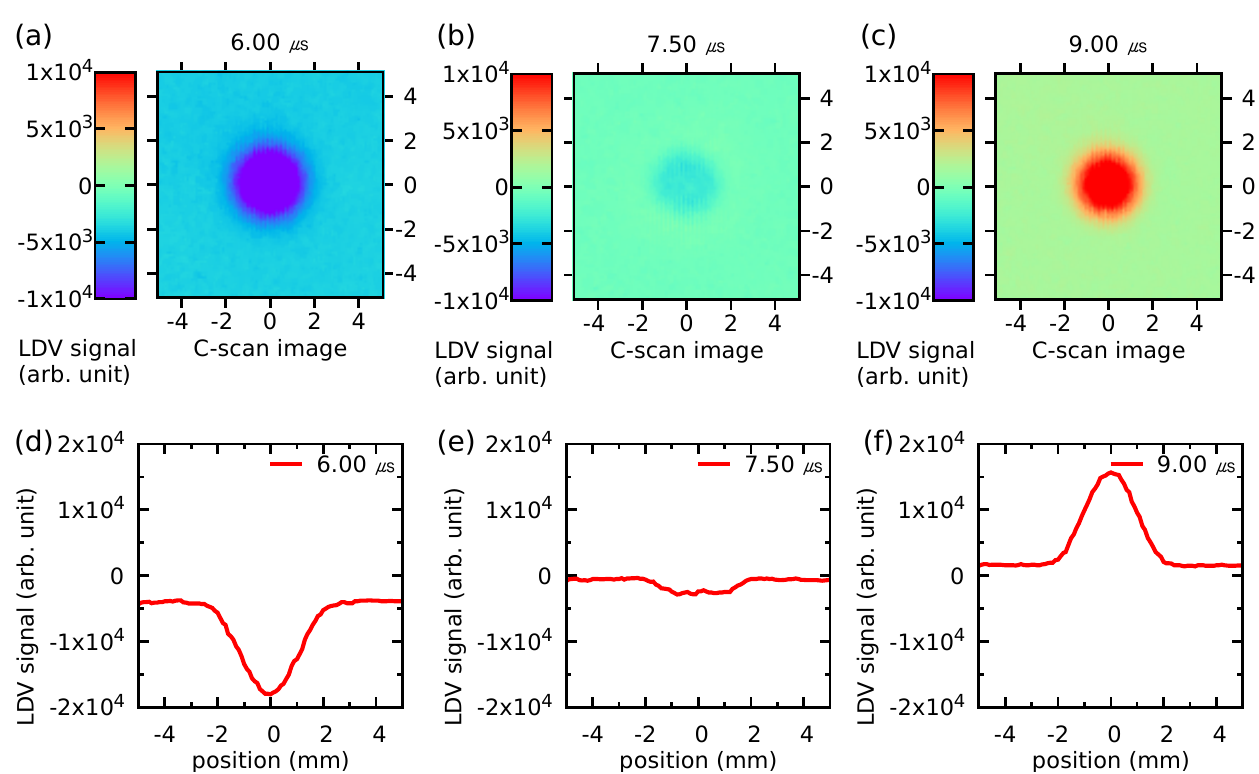
Figure 5. LDV signal distribution for Defect-1.0 of the AL6061 specimen in Band1 and its variation over time: ( a – c ) C-scan images at 6.00, 7.50, and 9.00 µ s, respectively, and ( d – f ) LDV signals as a function of the x -position at the same measuring time as in ( a – c ), respectively. The zero positions in ( d – f ) are the same as the origins in ( a – c ).